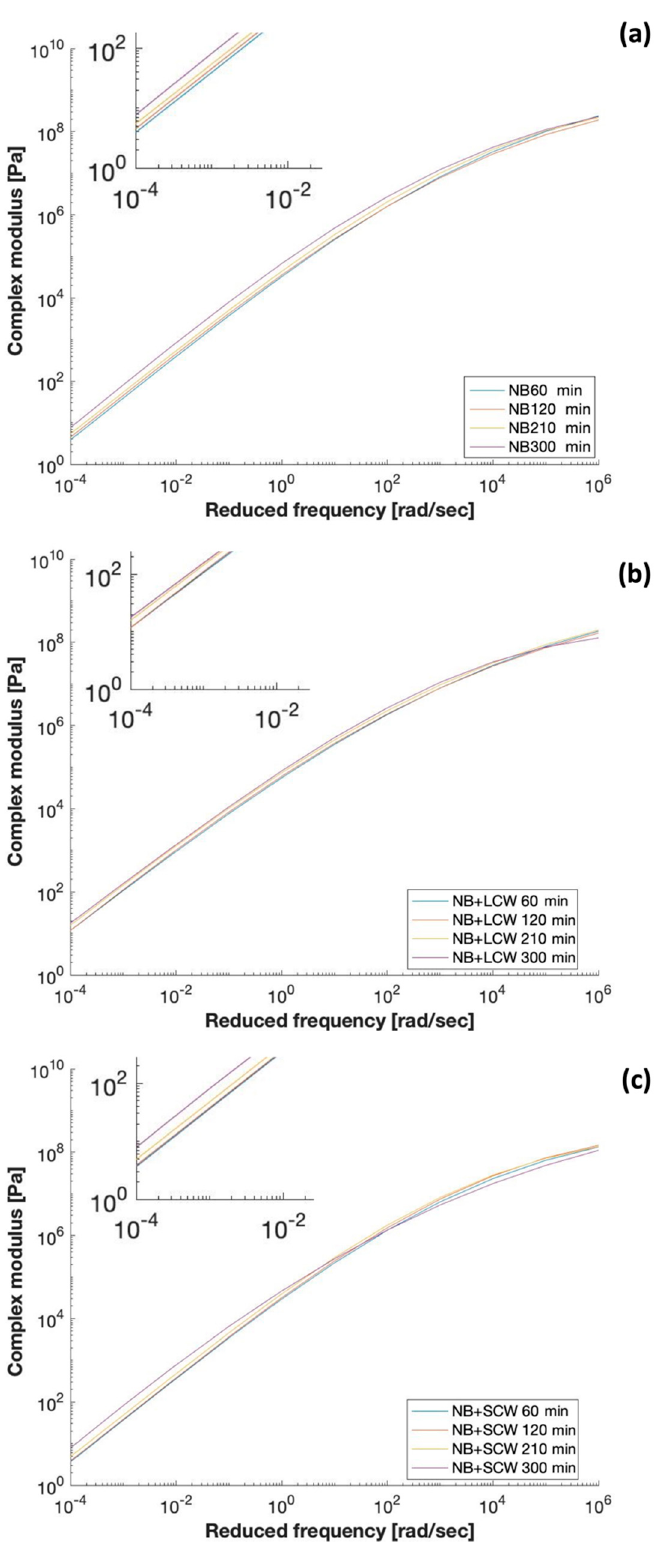
Figure 3. Time-evolution of linear viscoelastic properties of ( a ) NB, ( b ) NB+LCW, and ( c ) NB+SCW.